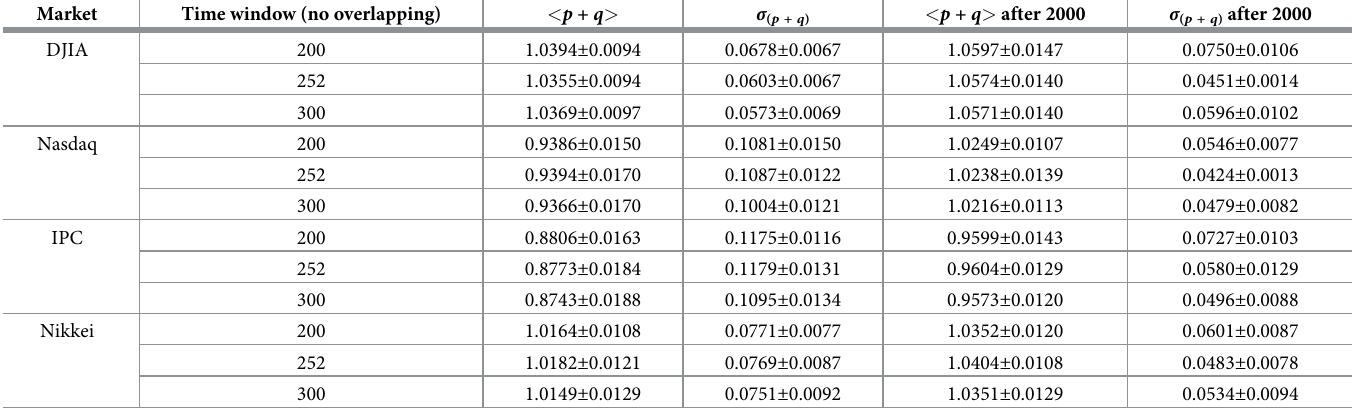
Table 11. Again, mean and standard deviation of p + q distributions, this time calculated by using 200, 252 and 300 no overlapping time frames. Displayed values are consistent with those of Table 10. Market